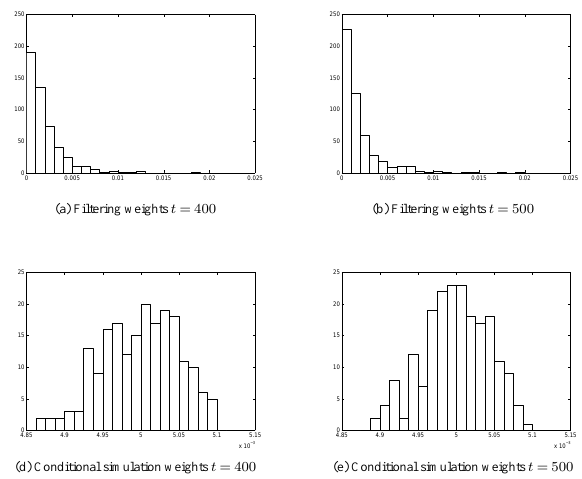
Figure 6. Filtering and conditional simulation weights. Fig. 6: Filtering and conditional simulation weights